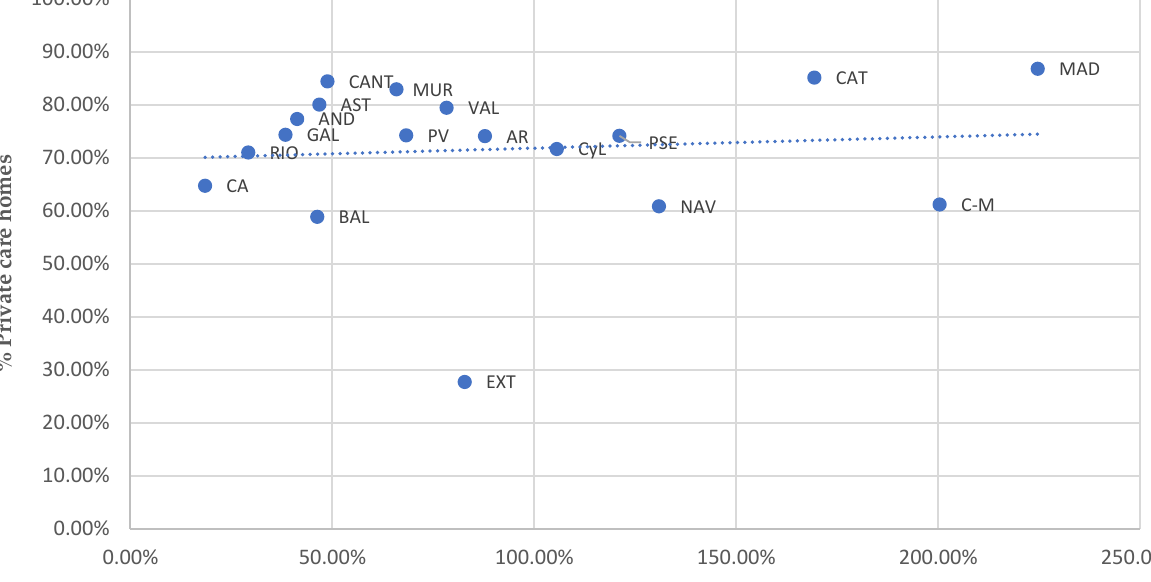
Table 3. Linear regression model after eliminating non-significant independent variables.